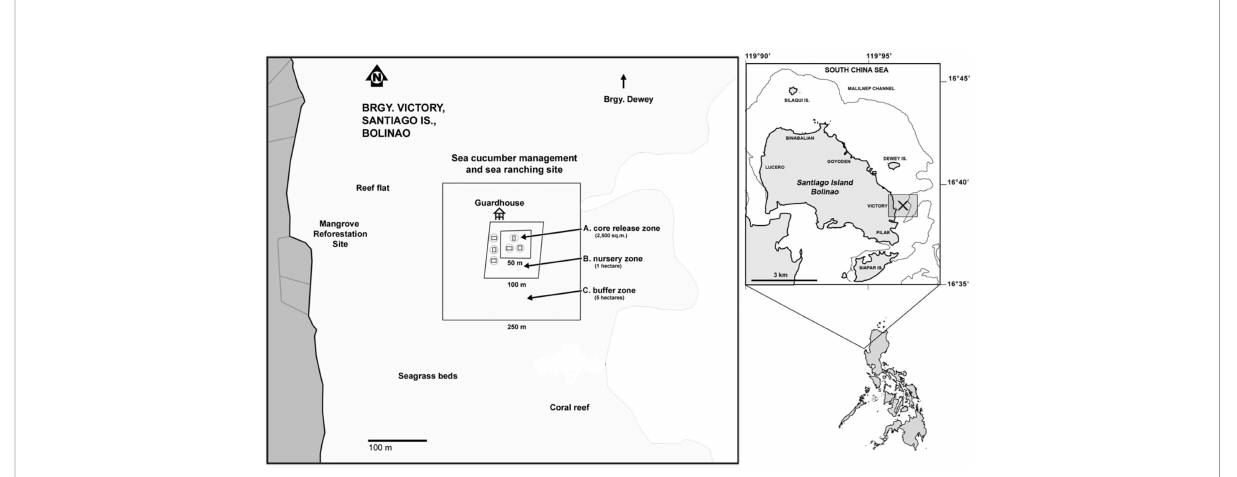
FIGURE 1 Map showing the location and the zonation of the 5-ha community-based sea cucumber ranch in Barangay Victory, Bolinao,